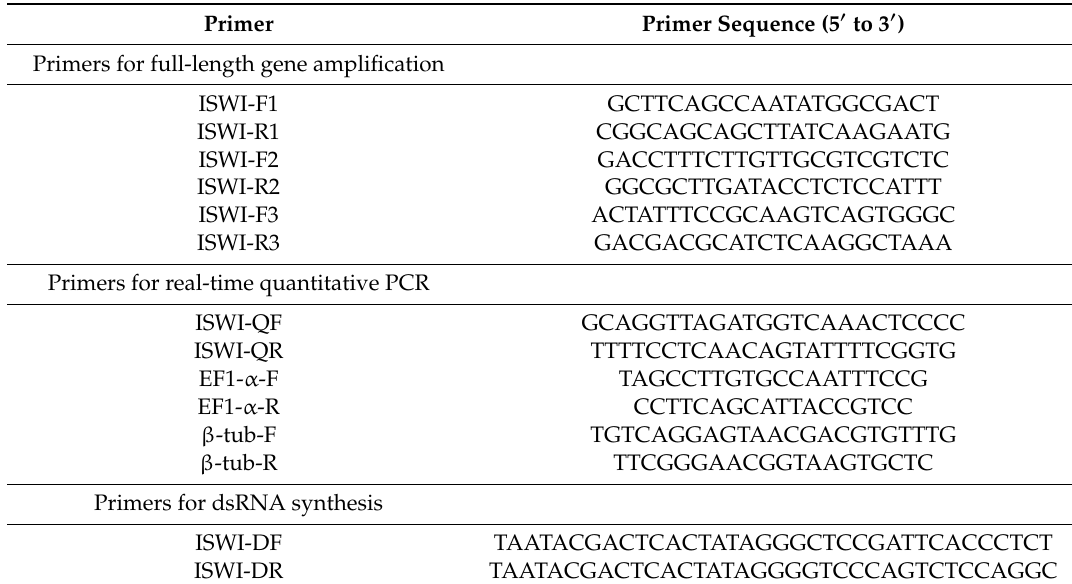
Table 1. Primers used for cDNA cloning, qRT-PCR (Quantitative real time PCR), and dsRNA synthesis. Primer Primer Sequence (5 (cid:48) to 3 (cid:48)